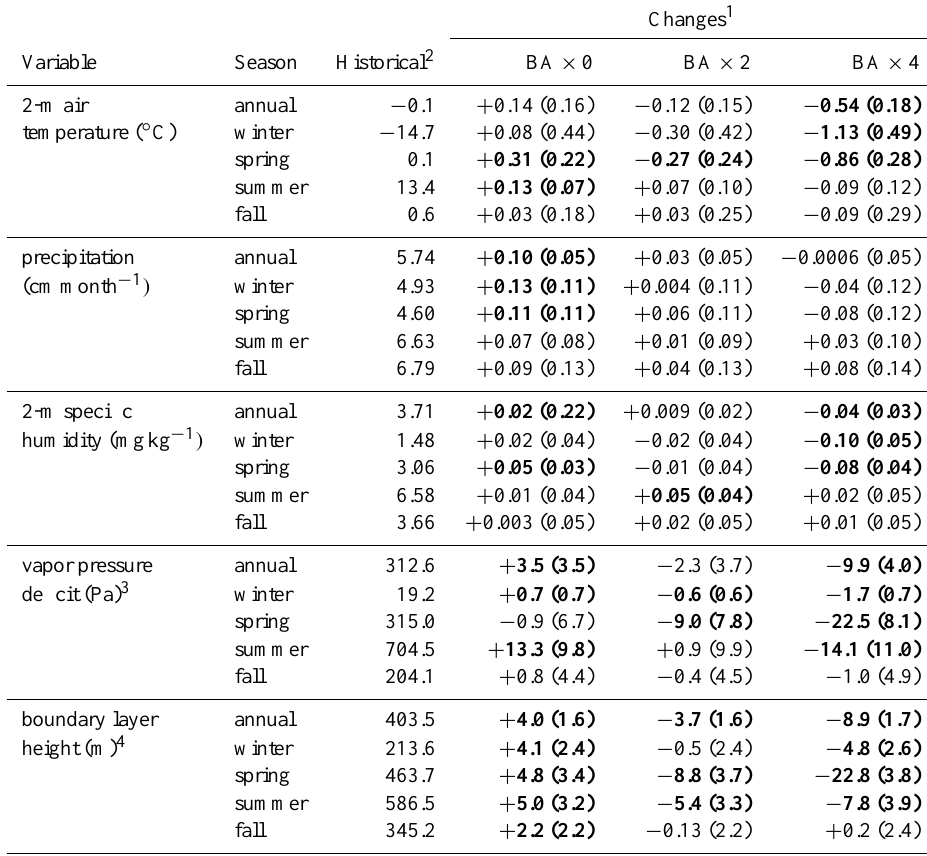
Table 3. Domain-wide climate means and anomalies from coupled simulations.